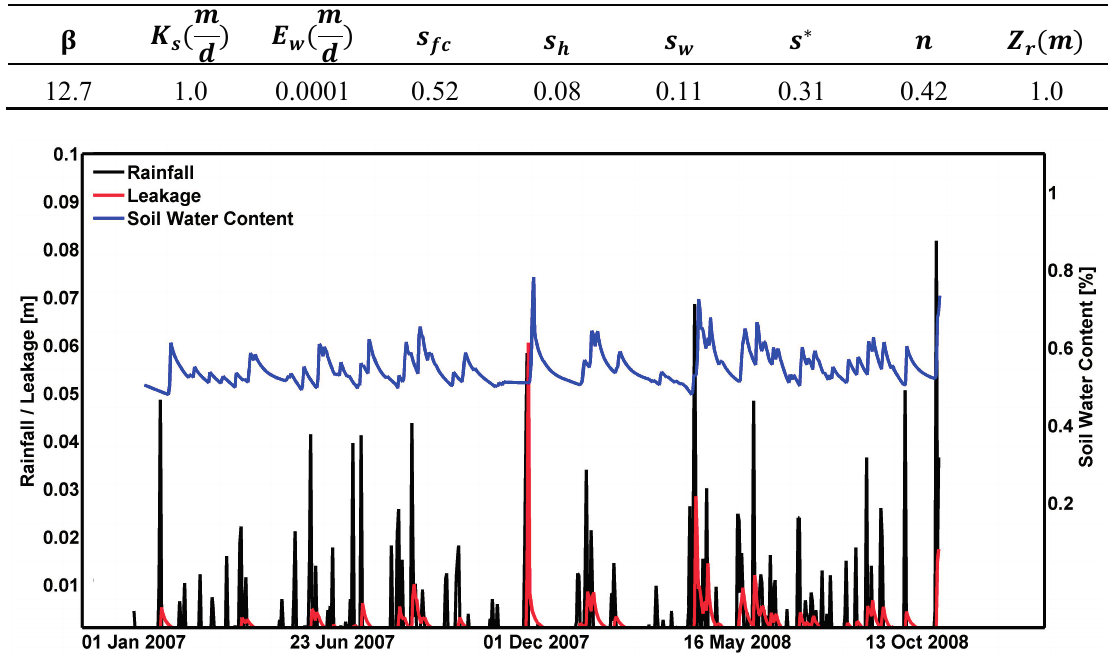
Table 1. Parameters of the leakage model (reproduced from Table 1, Section 2.6 of [68]).